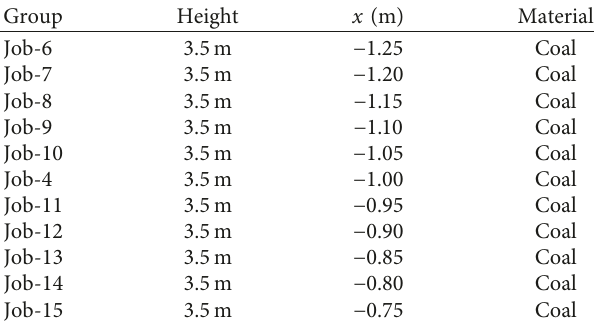
Table 3: Parameters at different